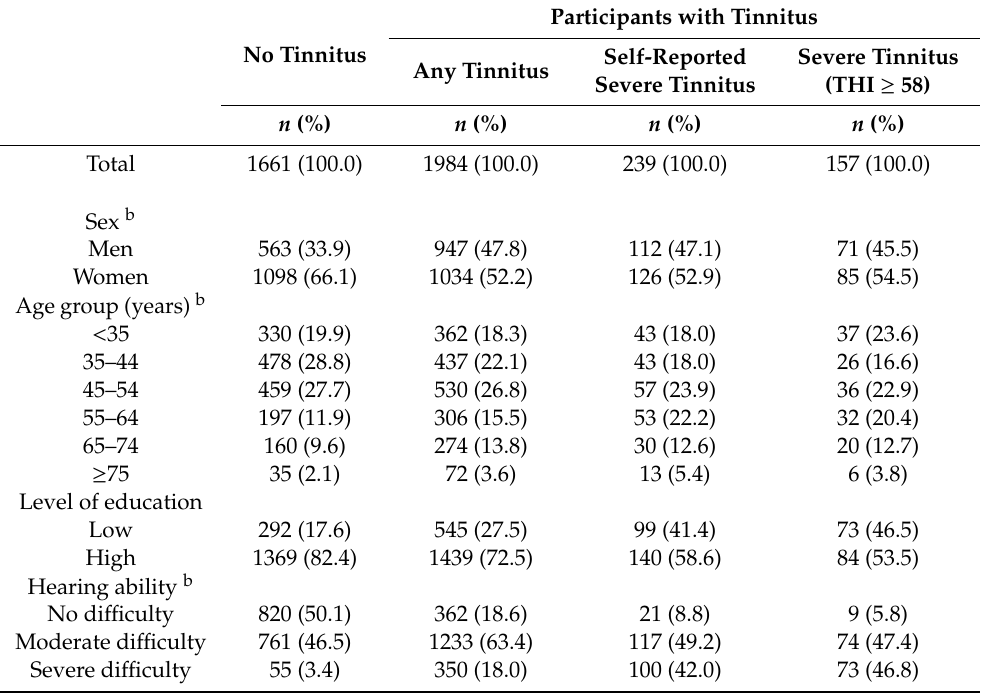
Table 1. Distribution of 1661 participants without tinnitus and 1984 participants with tinnitus a (157 with a severe tinnitus measured by THI, and 239 with a self-reported severe tinnitus), according to sex, age, level of education, and hearing ability. Sweden, 2016–2018. Participants with Tinnitus No Tinnitus Self-Reported Any Tinnitus Severe